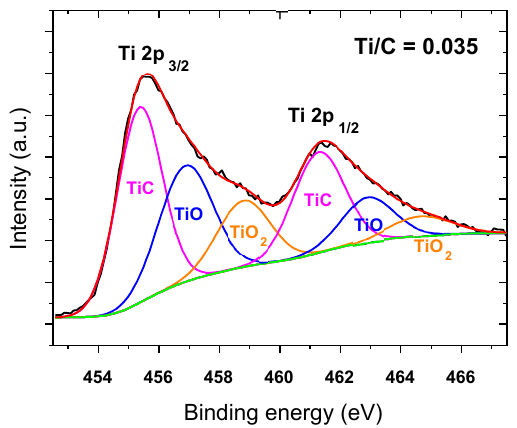
Figure 5. Ti2p XPS spectra of Ti-DLC coatings for Ti/C = 0.035.